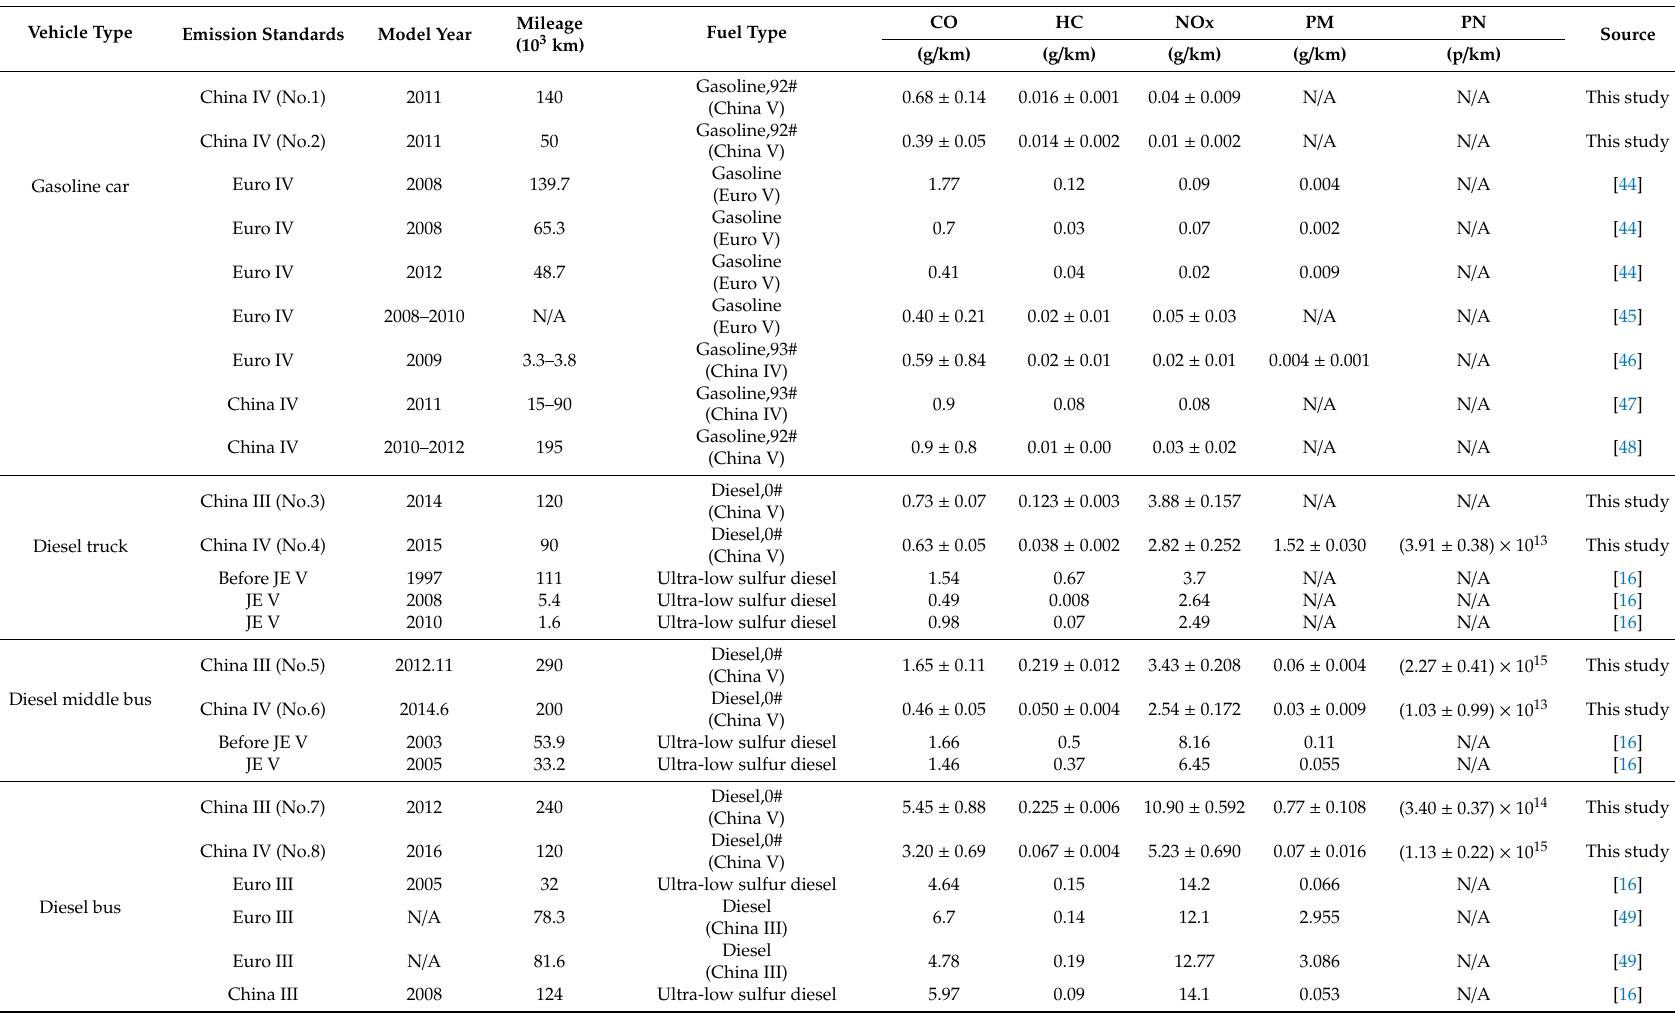
Table 2. Emission factors (average ± 95% confidence interval) of test vehicles and comparison with previous